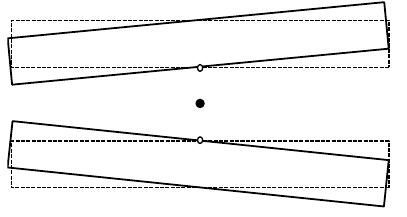
Figure 4. Outline of deformed inlet.